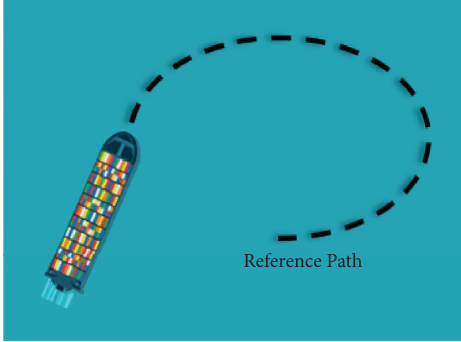
Figure 1: First scenario illustration.